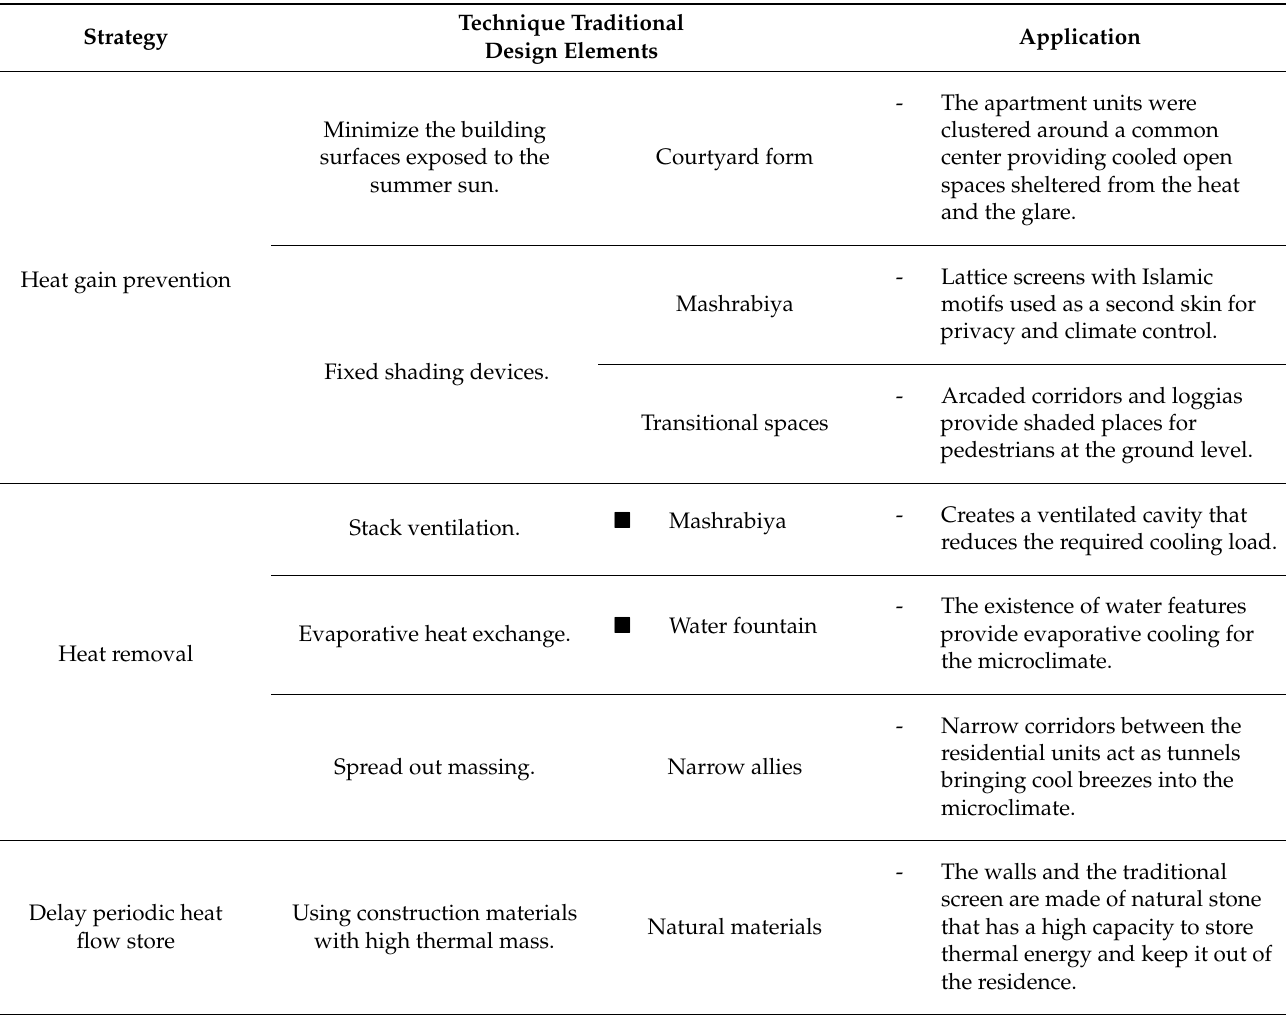
Table 8. Design strategies, techniques, and elements applied in the case of the Muttawar Sustainable Residential Housing Project